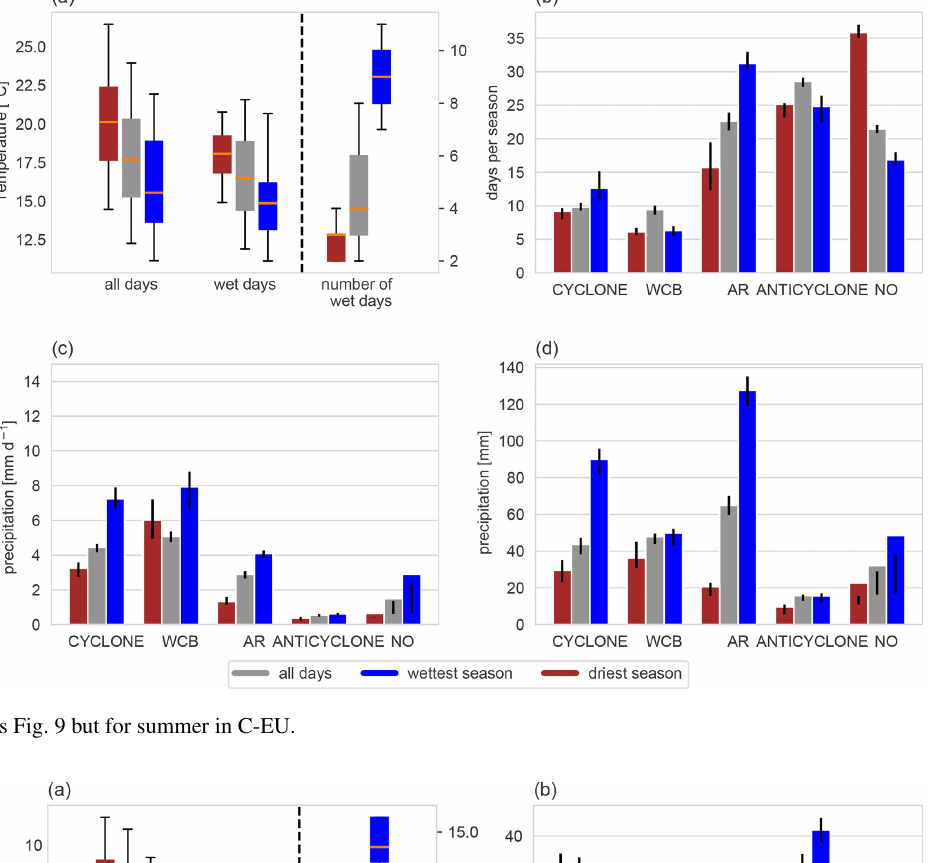
Figure 10. Same as Fig. 9 but for summer in C-EU.